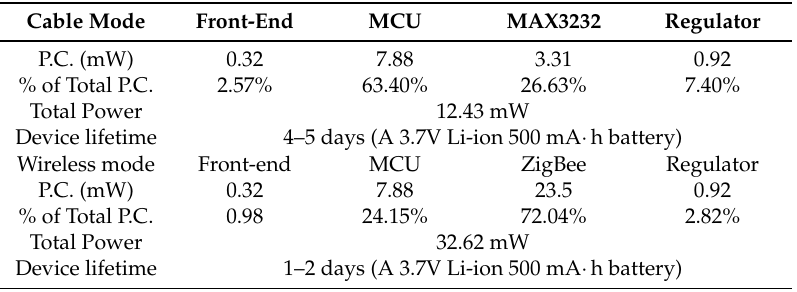
Table 2. Power consumption of the proposed readout system device in dual mode.